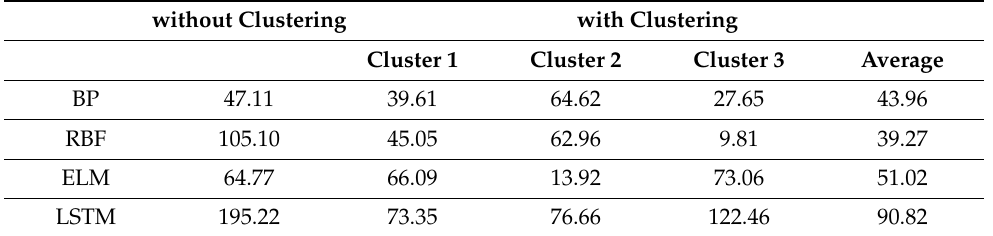
Table 5. RMSE of solar radiation forecast errors in autumn.